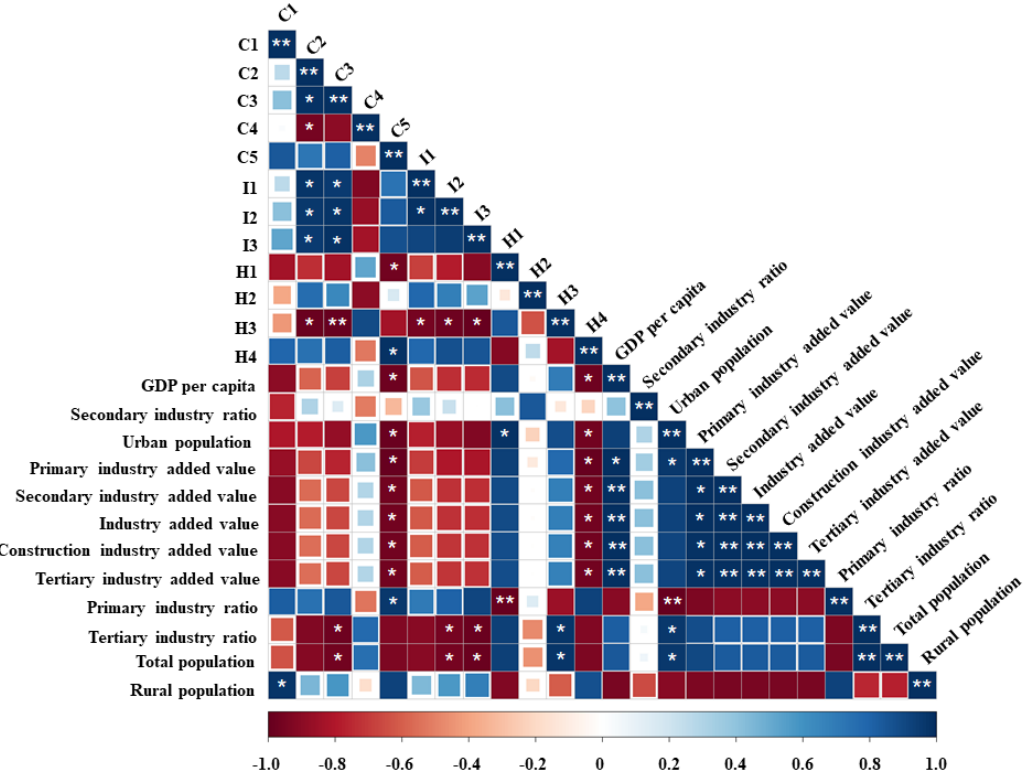
Figure 6. Similarity matrix of wetland types and socioeconomic factors. I1: River wetlands, I2: flood-